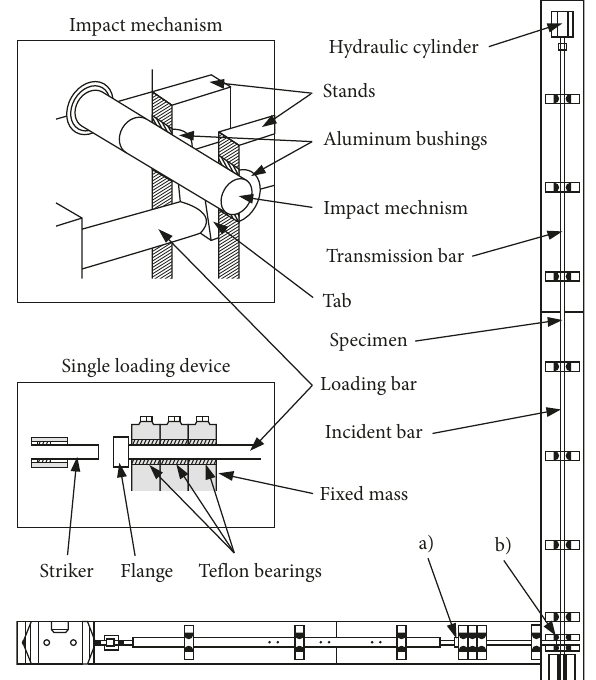
Figure 8: Direct impact loading TSHB developed by Claus et al.